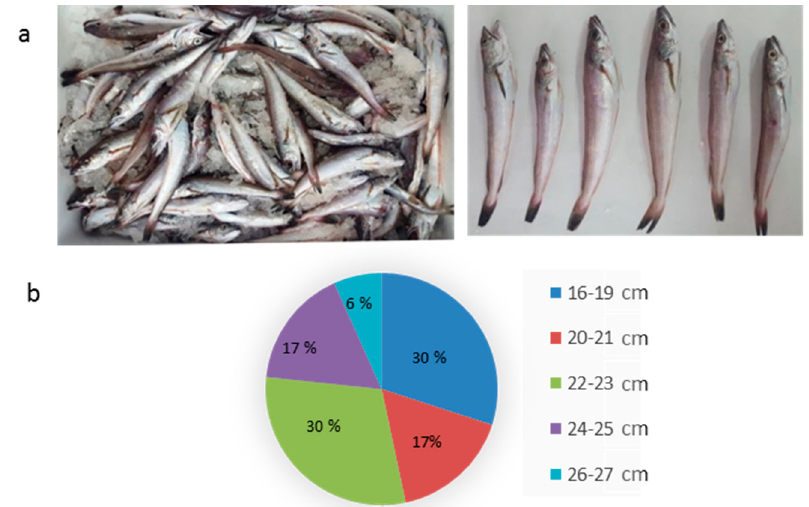
Figure 2. Photograph of some of the hake specimens used in the present study ( a ). Percentage of hake individuals of each size is shown in each sector of the diagram; ( b ) along with the corresponding size ranges (cm), which are indicated in the legend.